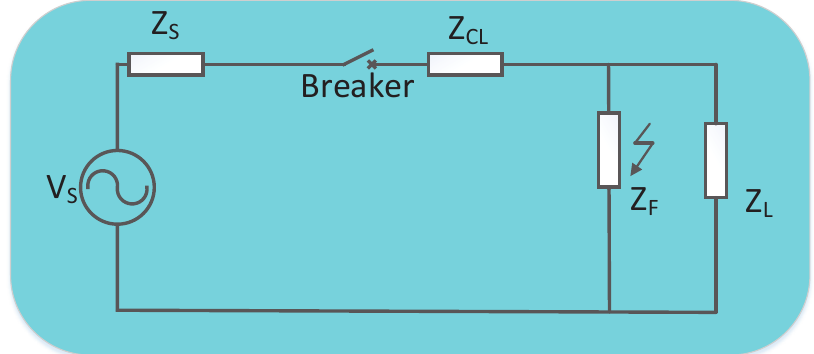
Figure 5. The equivalent circuit of the WECS with current limiter.